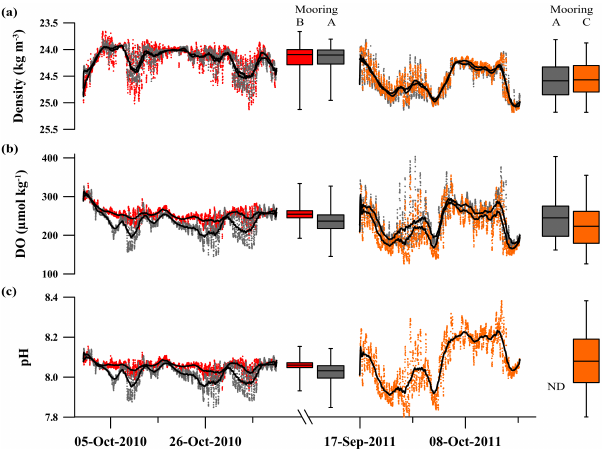
Fig. 7. Alongshore comparisons in density, dissolved oxygen (DO) and pH in the south and north La Jolla kelp forest. Time series and corresponding box plots of (a) density, (b) DO and (c) pH at south LJKF (mooring A; grey) and north LJKF (mooring D; blue) at 7m below the surface. Black solid lines are 2-d smoothed data. Den- sity scale is reversed. Box plot depicts the minimum, maximum, median, lower quartile and upper quartile for corresponding time- series data.